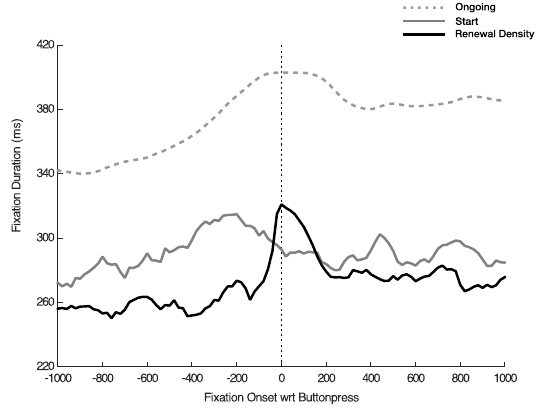
Figure 9. Fixation durations with respect to the button press. The average fixation duration of ongoing saccades is very high, due to the bus stop paradox (grey dashed line). The distribution of fixation duration of starting fixations is shifted left, peaking well before the button press. The simulated fixation duration based on assumed steady state renewal density allows a higher temporal resolution of gaze dynamics (black